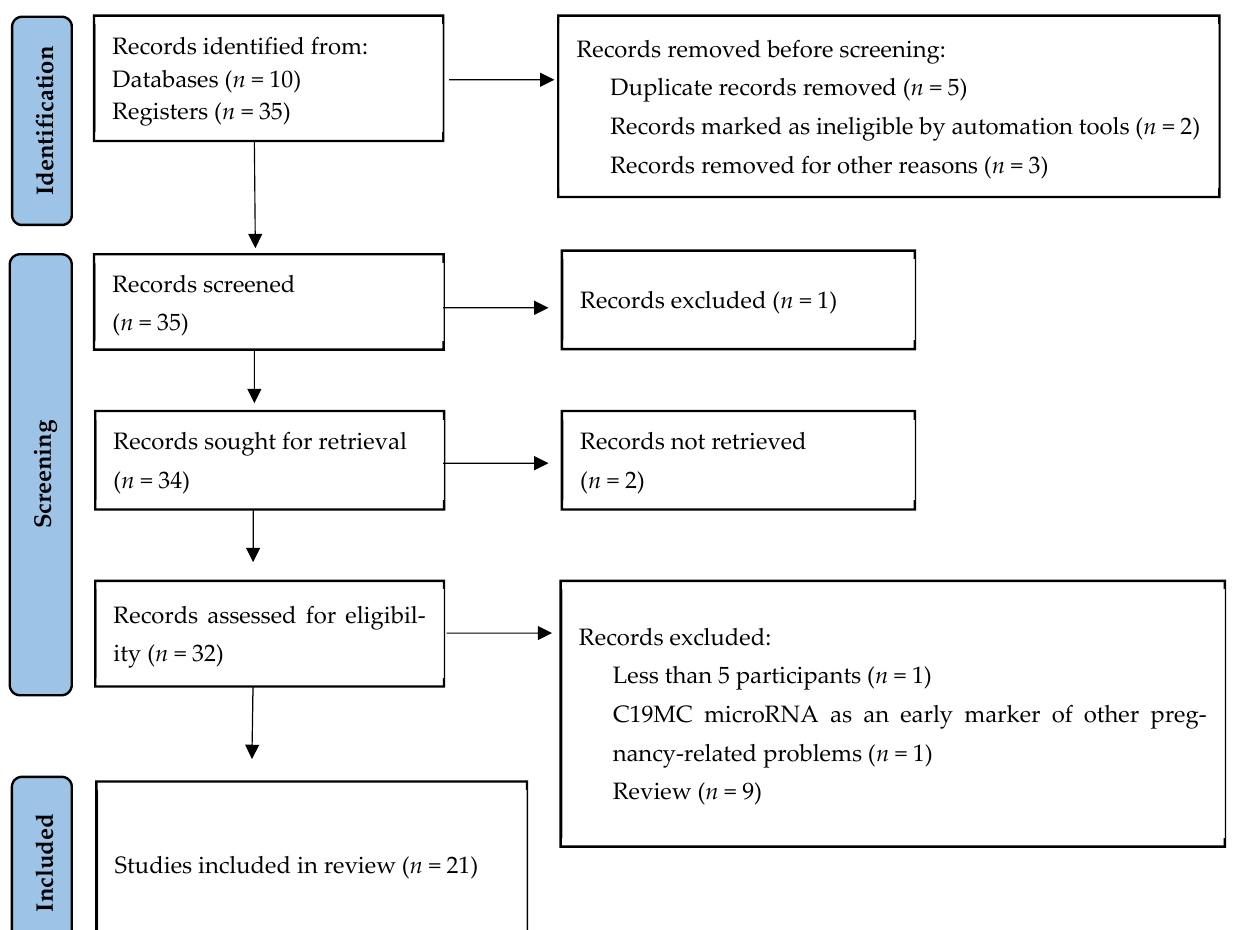
Figure 1. PRISMA chart showing the different stages of the systematic literature review. Ten records were retrieved from databases: PubMed, CINAHL, Web of Science, Scopus, and EMBASE. Thirty-five records were retrieved from registers: disease registries, pregnancy registries, and pregnancy exposure registries. Before the screening, 5 duplicate records were removed, 2 were marked as inel- igible using RobotAnalyst, and 3 records were removed because they were written in languages other than English. Thirty-five records were screened, and one was excluded, as its abstract did not